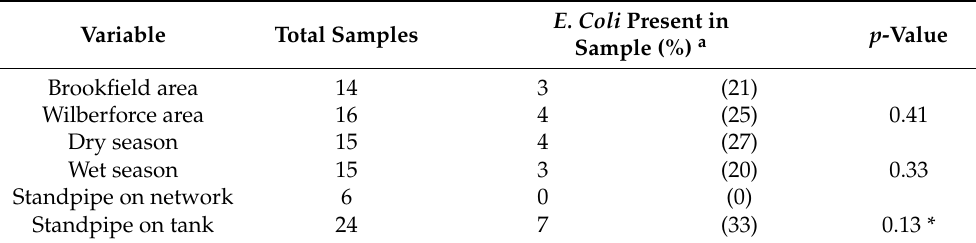
Table 3. Number of samples with E. coli present at an intermediate risk level or above, using the MPN method values in water from standpipes in Freetown, Sierra Leone.